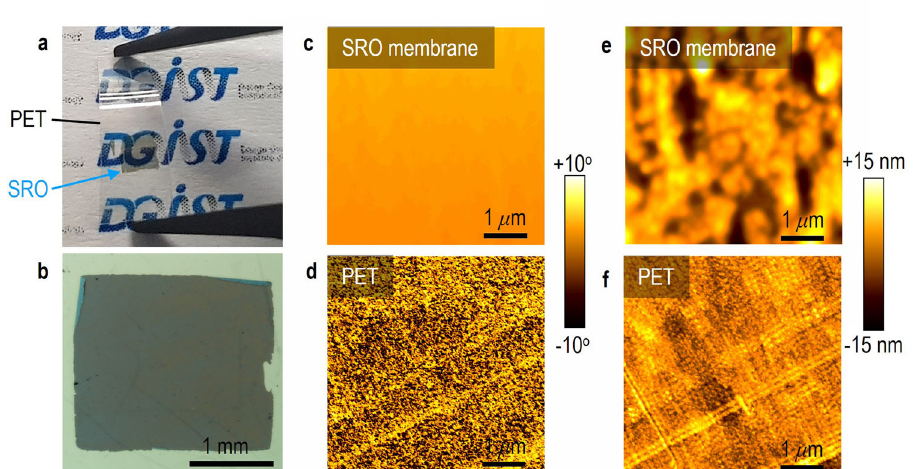
Fig. 2 Clean surface of the fl exible SC SRO membranes. a Photograph showing the background ‘ DGIST ’ logo to demonstrate the fl exibility of membrane, with the form SRO thickness used for convenience. b Optical microscopy image of 2.5 × 2.5-mm 2 -wide SRO 15nm our SRO 15nm PET substrate a clean surface. An atomic force microscopy image reveals a more uniform phase on the randomly selected 5 × 5 μ m 2 surface of the c SC SRO membrane than that of the d treated PET. The root-mean-square roughness of the e SC SRO membranes was only ~2.9 nm, comparable to the ~2.4 nm of f PET.